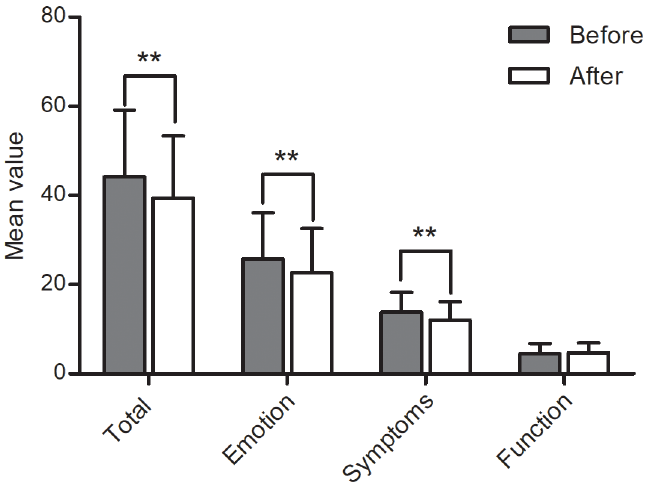
Fig 1. Rosacea: Pre- and post-treatment scores on the adjusted RosQol. After a four-week treatment course, there was a difference between pre- and post-treatment total and dimensional scores on the adjusted RosQol (cid:3)(cid:3) p <